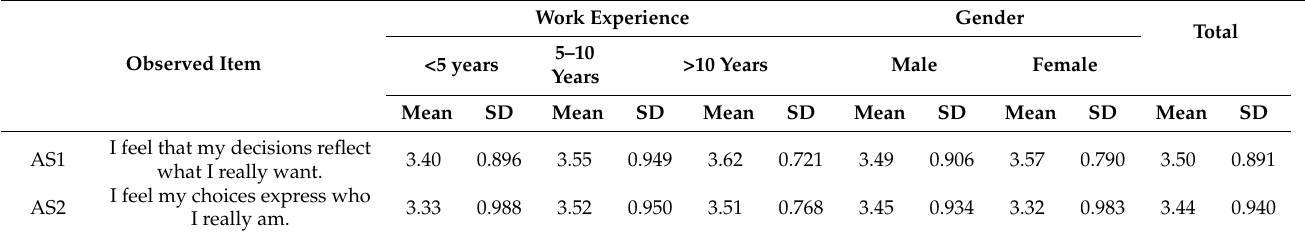
Table A5. Selected items related to BPNS variables and motivational subscales of the work experience and gender